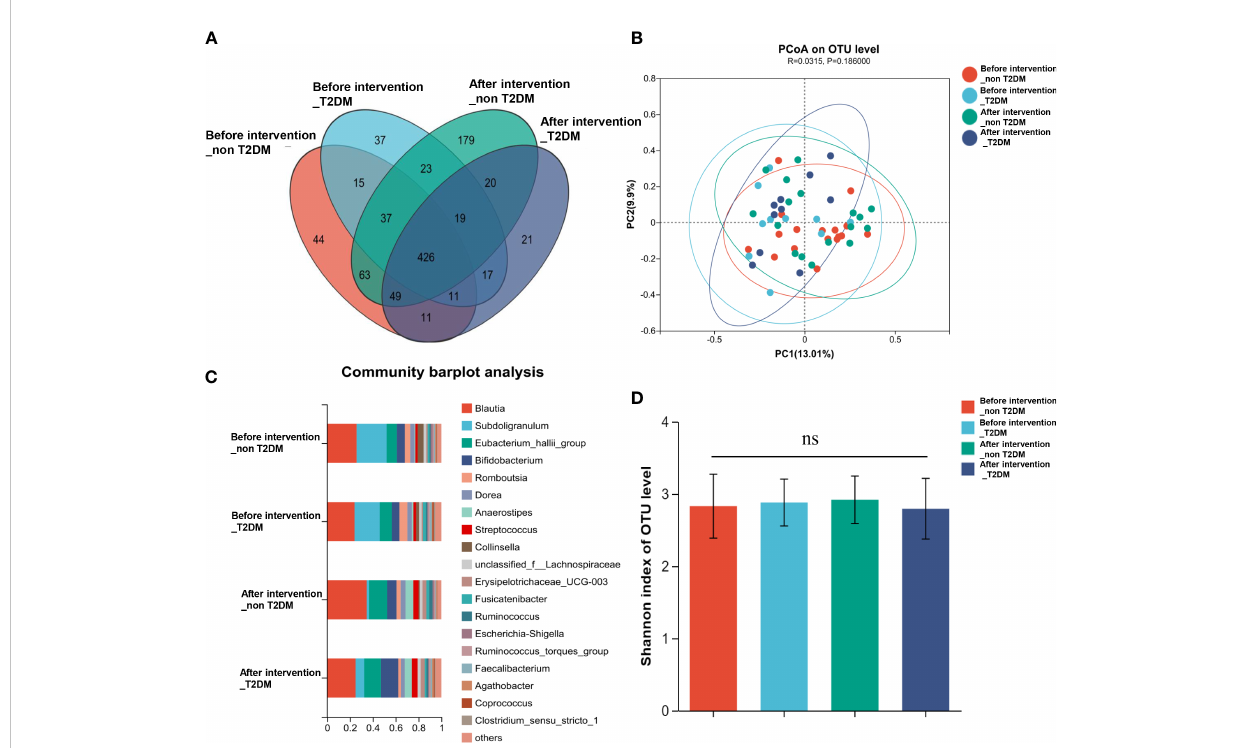
FIGURE 5 Composition and diversity of gut microbiota in T2DM patients and non-T2DM patients before and after two years of probiotics intervention. (A) The Venn diagram shows the common or endemic species between groups in the level of OUT; (B) Weighted UniFrac PCoA; (C) Compositional change at the genus level; (D) a diversity analysis of gut